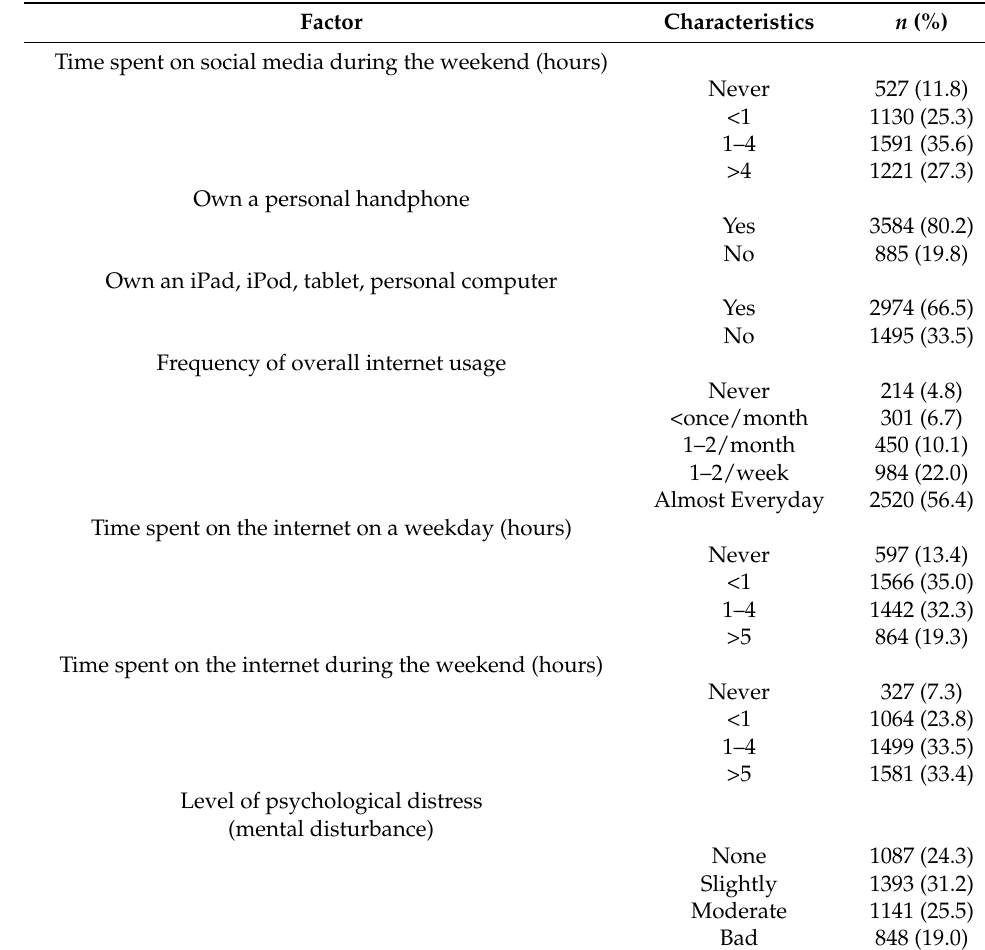
Table 1. Cont. Factor